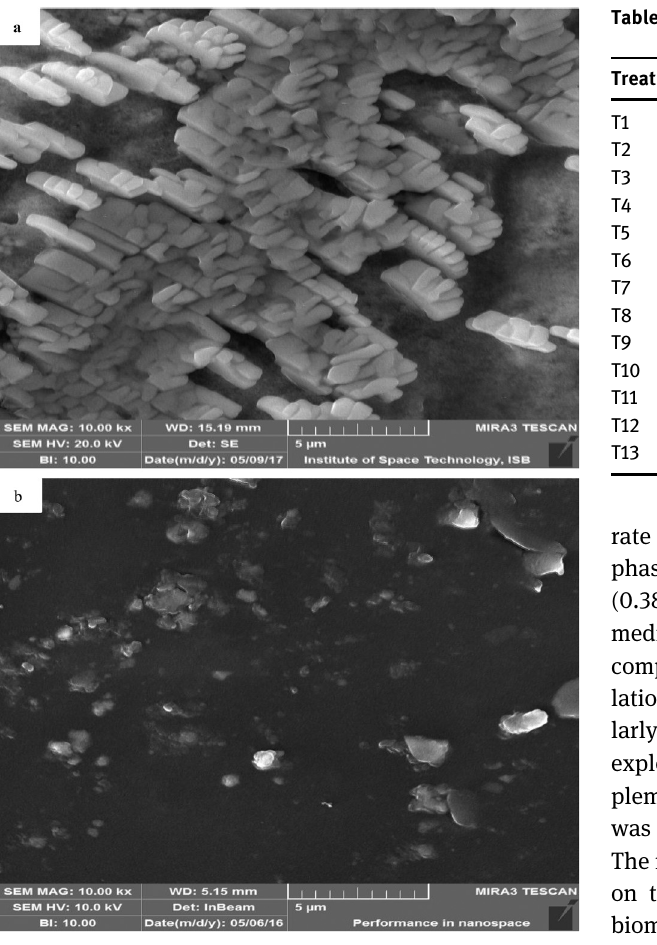
Figure 3: Scanning electron microscopy ( SEM ) micrographs of: ( a ) Ag NPs, ( b ) Cu NPs.